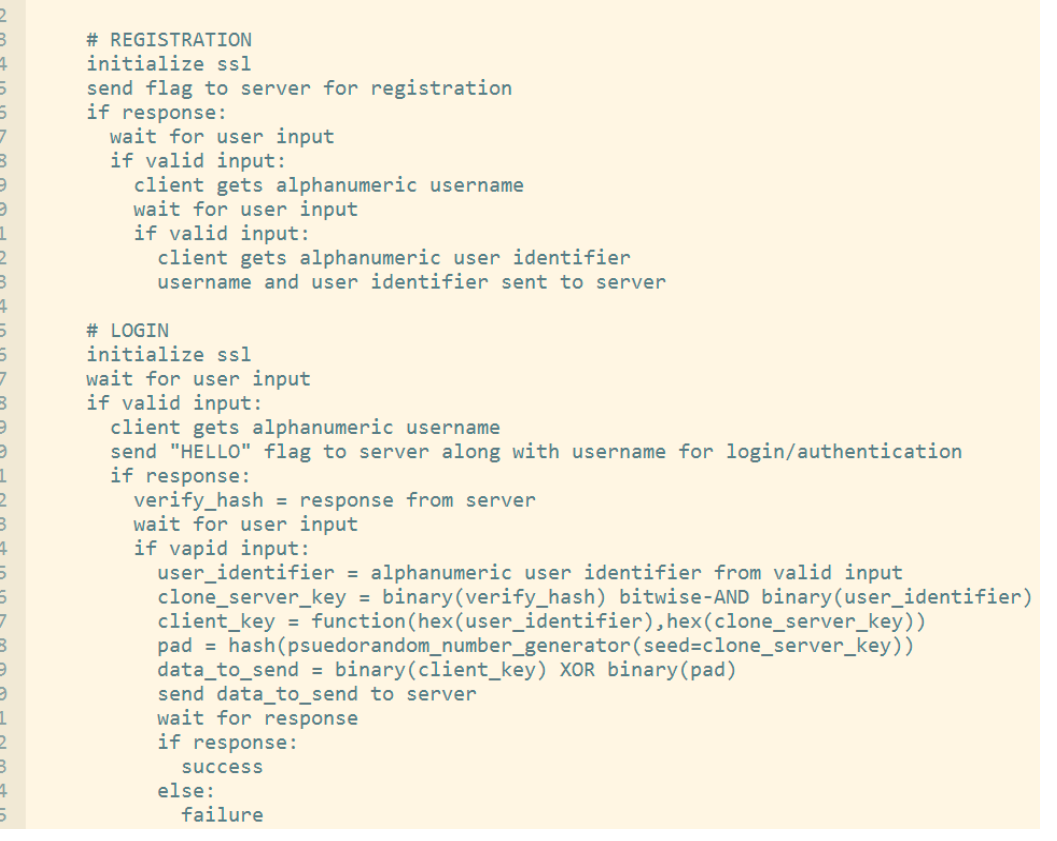
Figure 6. Code of client.